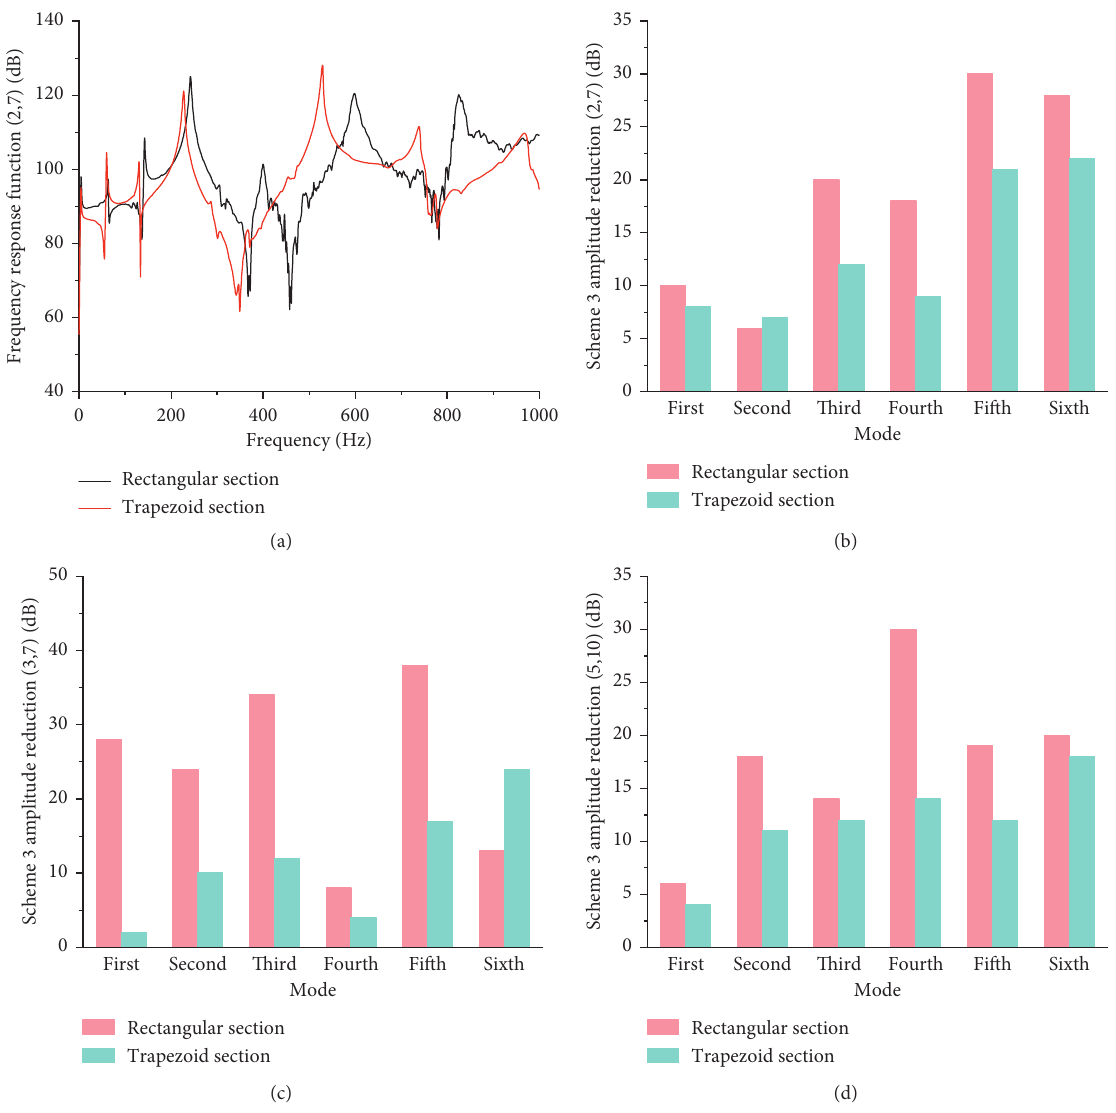
Figure 17: Comparison of frequency response curves and amplitude reductions of rectangular and trapezoidal cross sections before and after optimization. Table 6: Parameter calculation of the optimization model for schemes 2 and 3 for different cross sections. Model parameters (incentive response